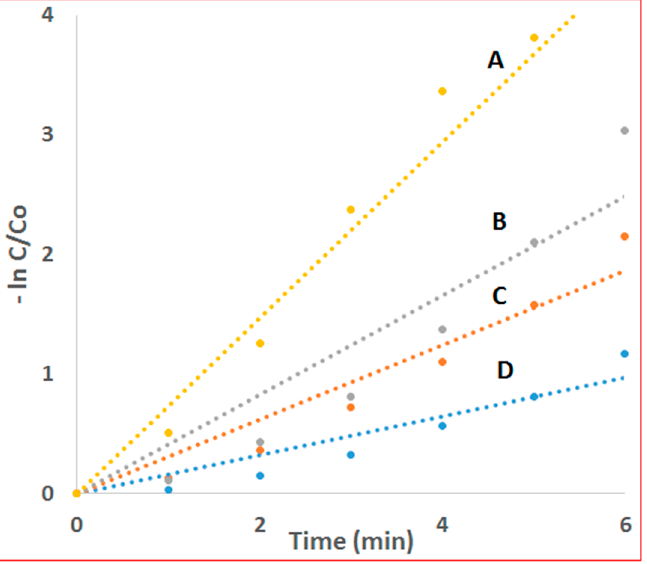
Figure 7. Regression curves of-ln(Ct/Co) versus irradiation time for (A) CNT-COO − /Ag 3 PO 4 @AgIO 4 -5%, (B) CNT/Ag 3 PO 4 @AgIO 4 , (C) Ag 3 PO 4 @AgIO 4 , (D) Ag 3 PO 4 . Table 1. MB degradation rate constants over the synthesized